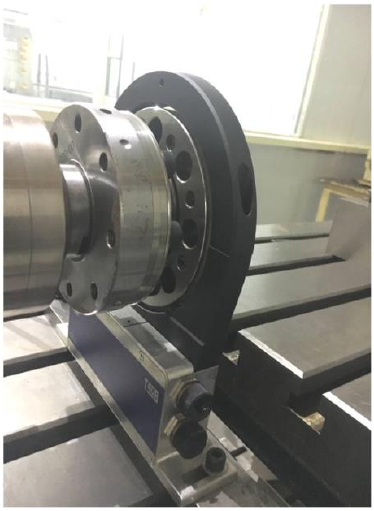
Figure 12. The prototype with torque flange.